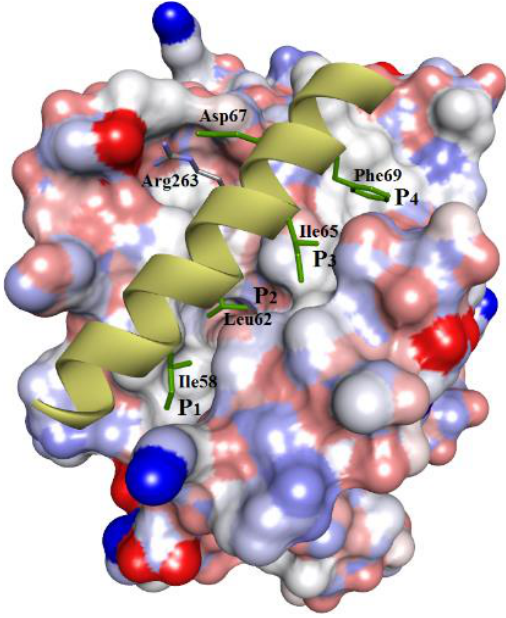
Figure 1. The crystal structure of hMcl-1 protein bound with a BH3 α -helix peptide provides information on the binding event (PDB id: 2PQK). The structure shows 4 pockets (P 1 , P 2 , P 3 , P 4 ) in the active site, with each hydrophobic amino acid side chain of the BH3 helix (H1, H2, H3, H4) utilizing these pockets.